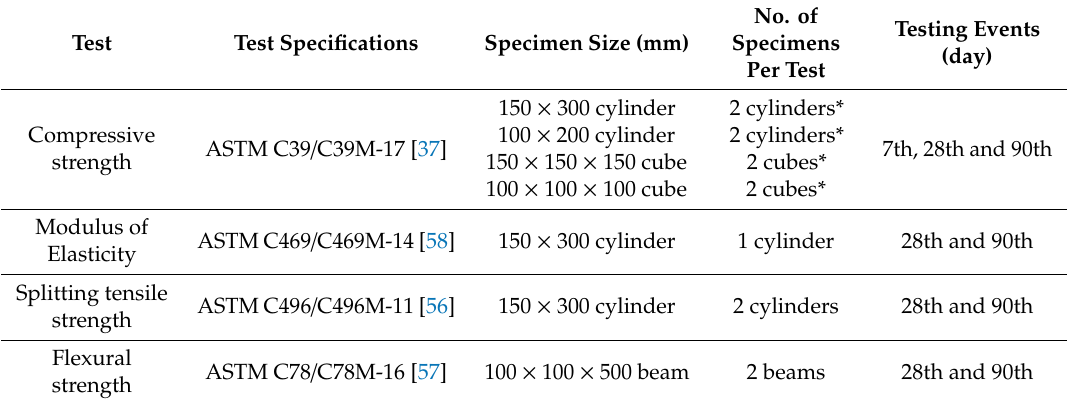
Table 6. Summary of the experimental